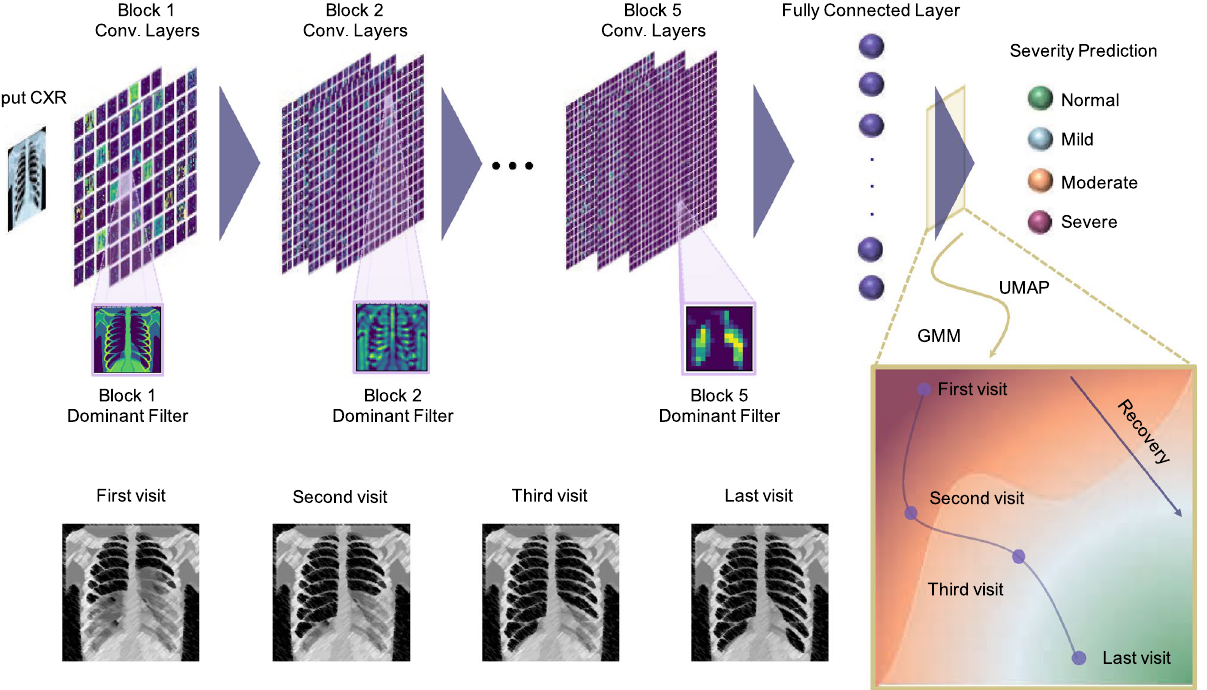
Figure 1. Workflow of COVID-19 severity assessment and prognosis model. The input CXR is fed into the CNN and will be processed by the network to extract the features and classify the severity degree of the disease. At each layer of the CNN, the outputs of the most dominant channels will be visualized using a pruning approach to understand the decision-making process and extracted features by the CNN. To monitor the progress of the disease, we reduce the dimensionality of the last fully connected layer using UMAP and use the Gaussian Mixture Model (GMM) to cluster the space into different severity regions. For series of input CXRs of a patient, we use the trained CNN to assess the severity degree at each visit and use the latent-space representation to visualize and monitor the progress of the disease in 2D space. Note that the X-ray images (from Vecto rStock) and figures are conceptual and the results for each part are presented in the following sections.